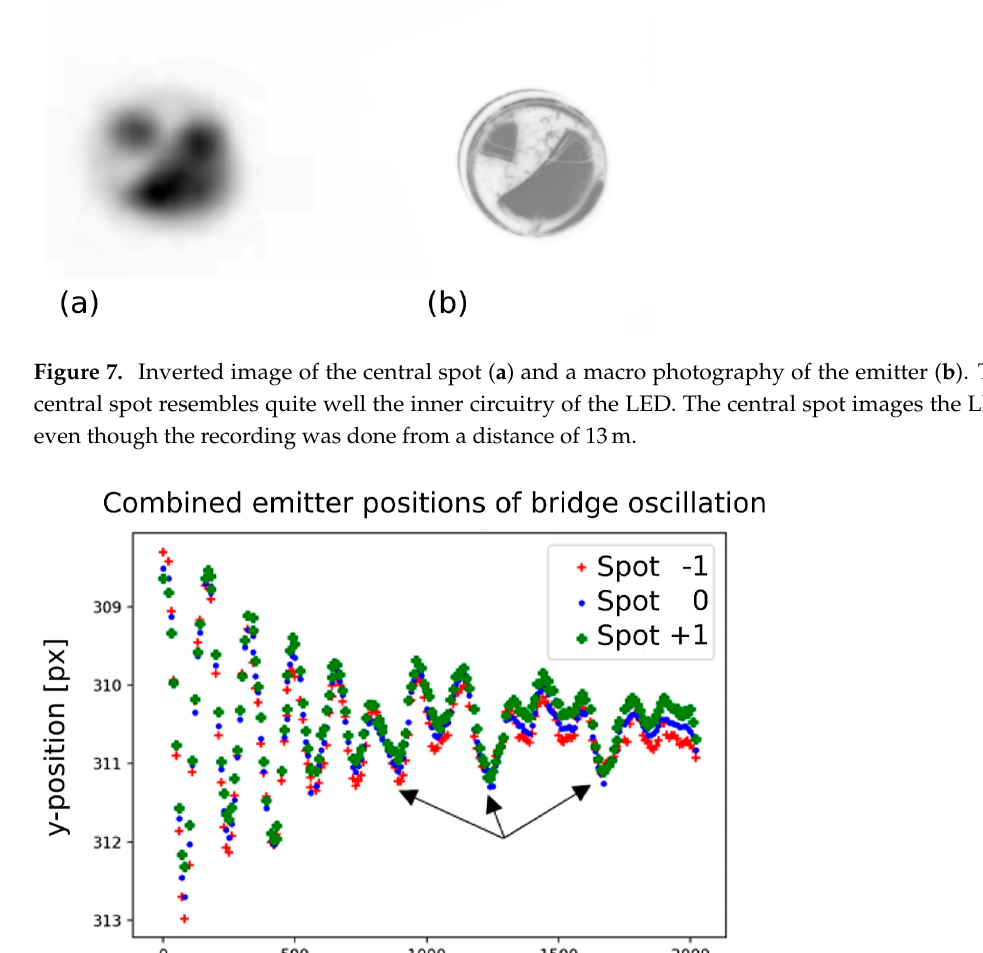
Figure 6. Spots as seen on the camera sensor. Spot − 1 and + 1 are smeared out compared with spot 0, which is much more focused.